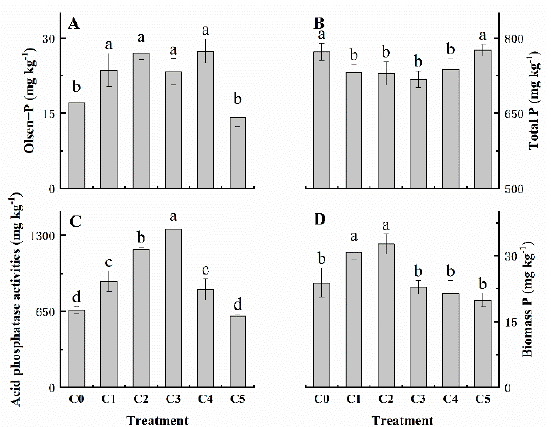
Figure 3. Changes of available phosphorus ( A ), total phosphorus ( B ), acid phosphatase activity ( C ), and microbial biomass phosphorus ( D ) in rhizosphere soil with different treatments. Different letters above columns indicate significant differences among treatments tested by one-way ANOVA ( p < 0.05).